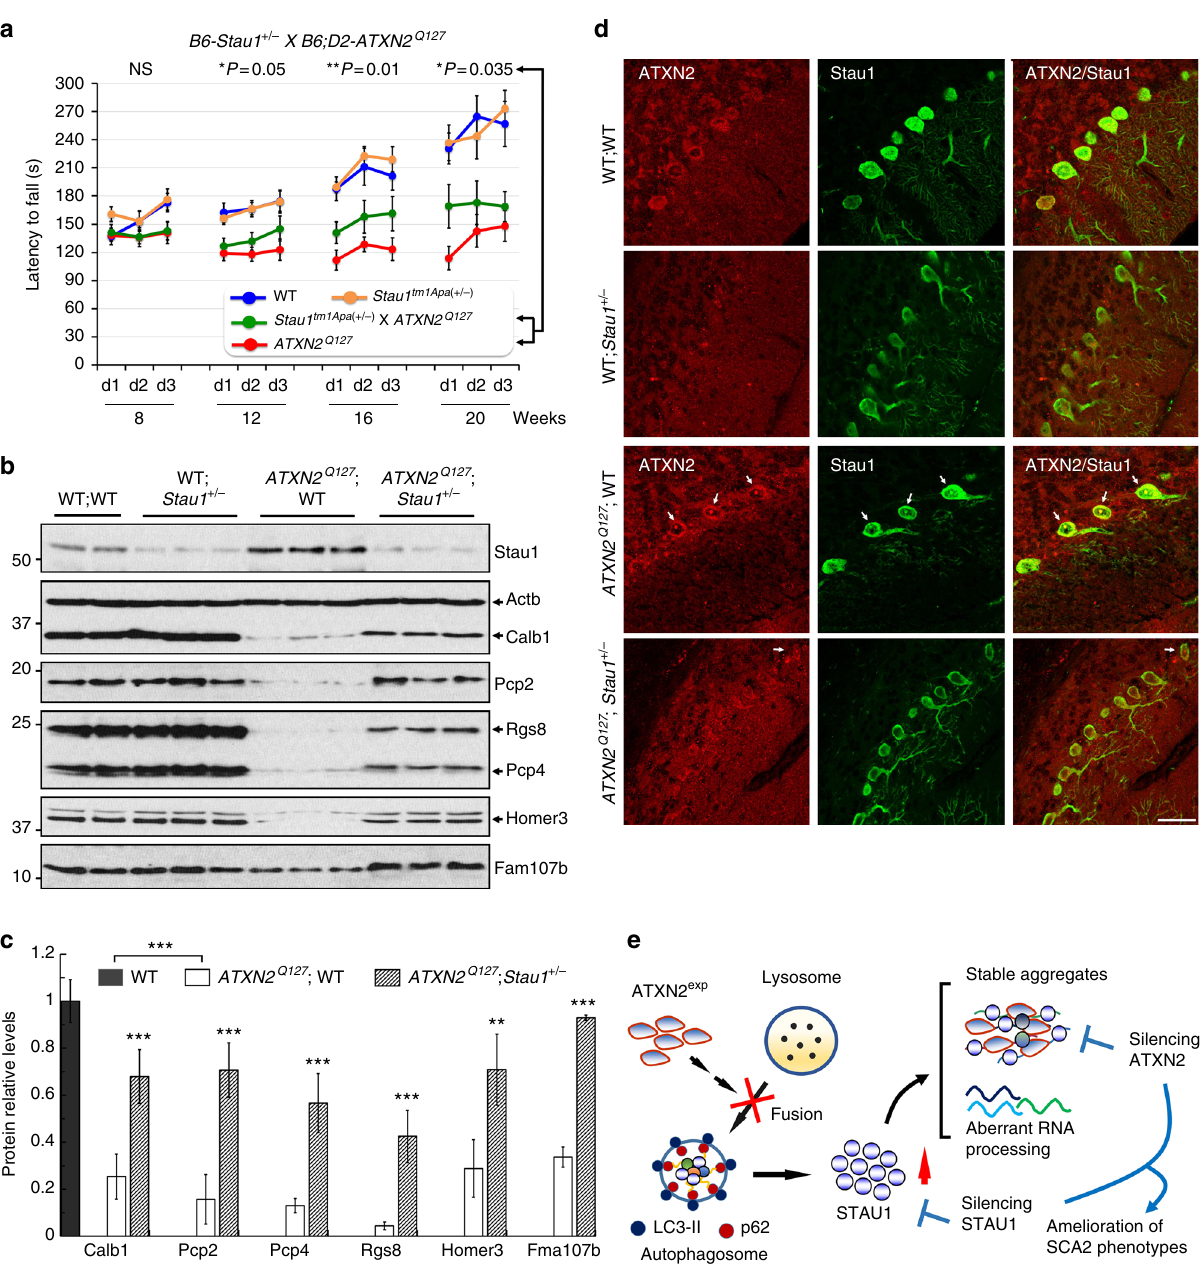
Fig. 7 Silencing of STAU1 mitigates SCA2 phenotypes. a Stau1 haploinsuf fi ciency improves abnormal motor behavior of ATXN2 Q127 mice as determined by rotarod behavior at 8, 12, 16, and 20 weeks of age. ATXN2 Q127 ; Stau1 + /- mice (green) have improved rotarod performance compared with ATXN2 Q127 littermates (red) starting at 12 weeks of age. Note that Stau1 haploinsuf fi ciency (orange) by itself does not alter motor function; n = 9 – 15 mice per group. Values shown are mean ± SE. Signi fi cance was determined using generalized estimating equations (GEE). NS, nonsigni fi cant, * P < 0.05, ** P < 0.01. b , c Reduction of Stau1 in vivo improves levels of key cerebellar proteins towards normalization. b Western blotting of cerebellar extracts from ATXN2 Q127 ; Stau1 + /- mice showing improvement of protein levels for Calb1, Pcp2, Rgs8, Pcp4, Homer3, and Fam107b towards normalization. Each lane represents cerebellar extract from an individual mouse. β -Actin is used as a loading control and the blots are from three replicate experiments. c Quantitative analysis of western blots shown in b . Data are mean ± SD, ** P < 0.01, *** P < 0.001, Student t -test. d Combined immunostaining of ATXN2 (red) and Stau1 (green) of cerebellar sections from ATXN2 Q127 and crossed ATXN2 Q127 ; Stau1 + /- mice (34 weeks of age) demonstrating reduced ATXN2-Stau1 aggregates in crossed ATXN2 Q127 ; Stau1 + /- mice. Scale bar, 30 µ M. e Model for STAU1 in the pathology of SCA2 and other neurodegenerative